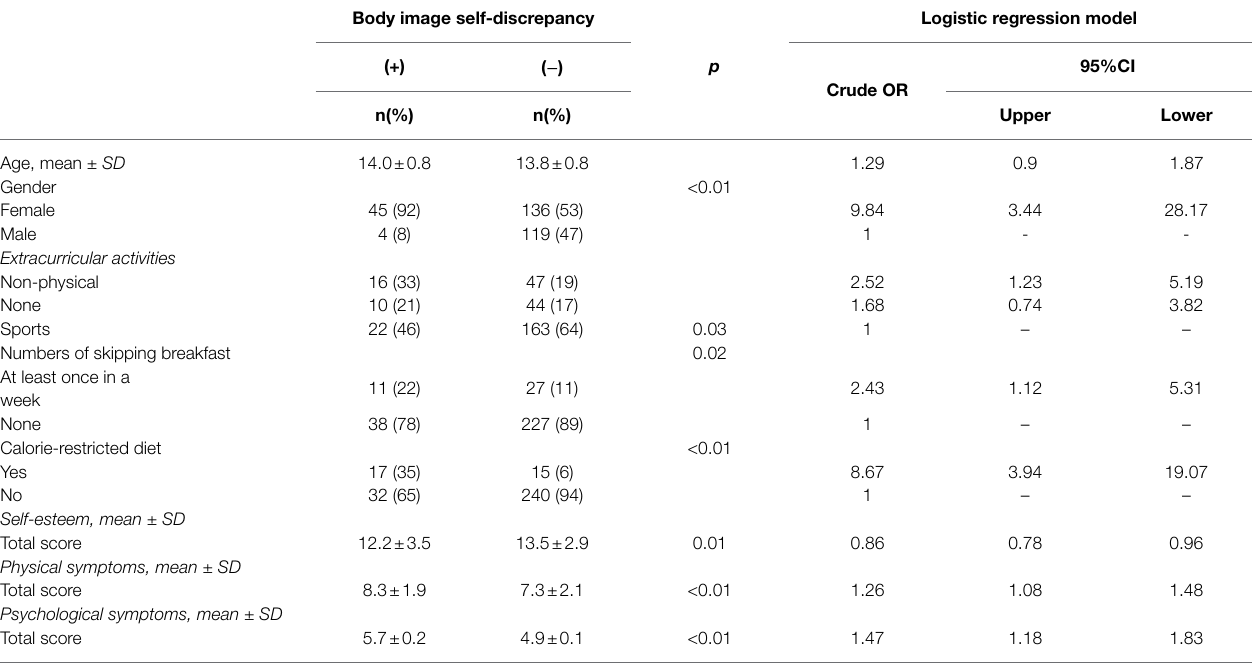
Body image self-discrepancy